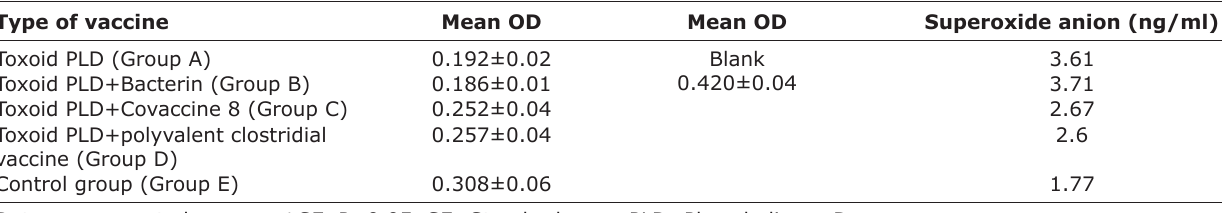
Table-1: Effect of the four vaccine formula on superoxide anion liberation from triggered macrophages in tested sheep sera after 2 weeks from the challenge. Type of vaccine Mean OD Mean OD Superoxide anion (ng/ml) Toxoid PLD (Group A) Toxoid PLD+Bacterin (Group